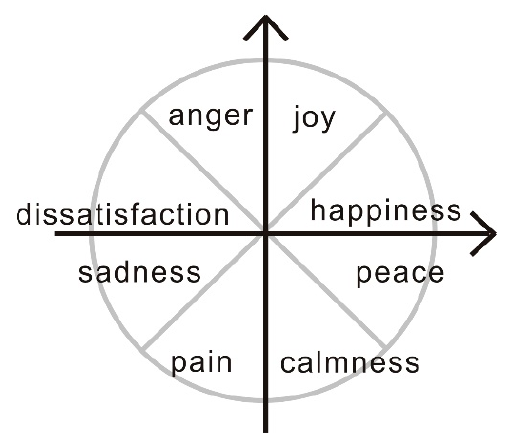
Figure 2. Emotion categories in the vector space.